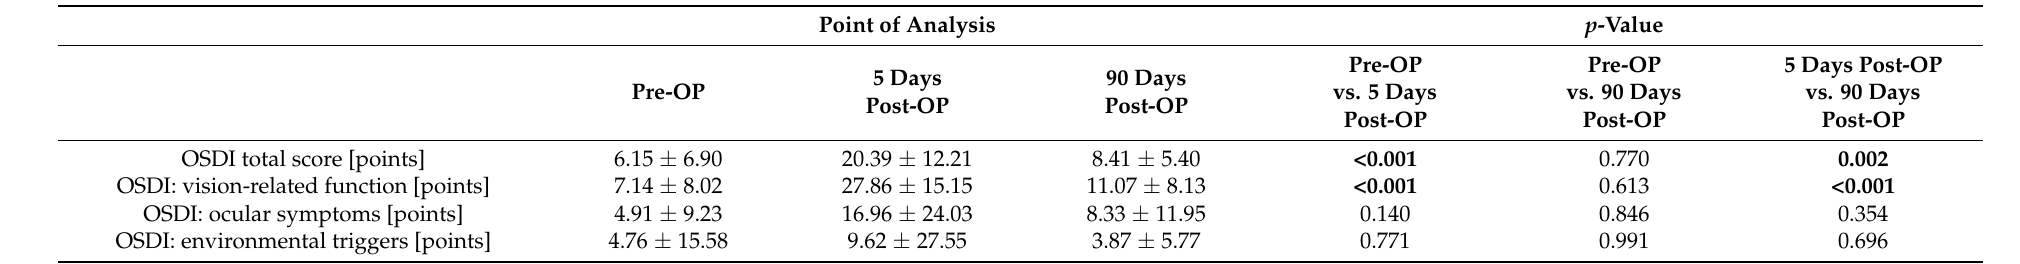
Table 3. Detailed OSDI score (mean ± SD) before as well as 5 and 90 days after Femto-LASIK. Significant p -values are in bold. Abbreviation: OSDI = ocular surface disease